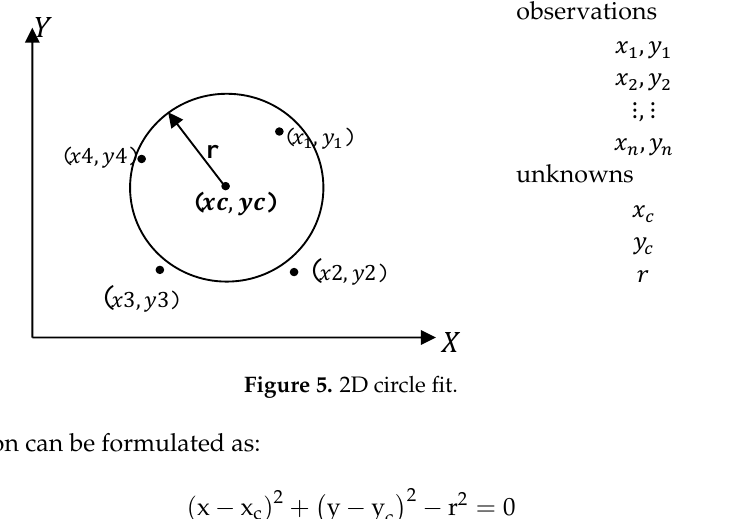
Figure.5. 2D circle fit . Figure 5. 2D circle Figure 5. 2D circle fit.